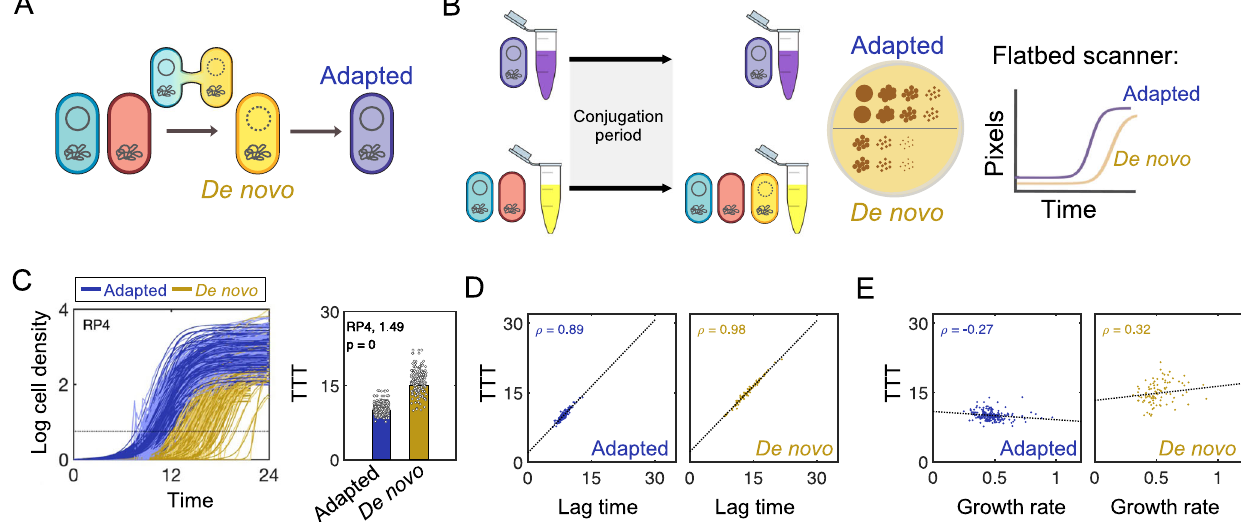
Fig. 1 | Quantifying plasmid acquisition costs with single-colony resolution. A Schematic illustration of conjugation between a donor (blue)and recipient (red) cell, generating a de novo transconjugant (yellow). Over time, the de novo trans- conjugant adapts to the plasmid, becoming an adapted transconjugant (purple). B Schematic illustration of the acquisition cost protocol. C Left: Log cell density in pixels (y-axis) of RP4 de novo (yellow, n =96) and adapted (purple, n =208) transconjugants over time (x-axis, hours). The black horizontal line indicates the time-to-threshold (TTT)inhours.Right:TTT(y-axis)ofdenovo(yellow)compared to adapted (purple) transconjugants. Markers correspond to the TTT of individual colonies pooled across seven independent biological replicates. Bar height